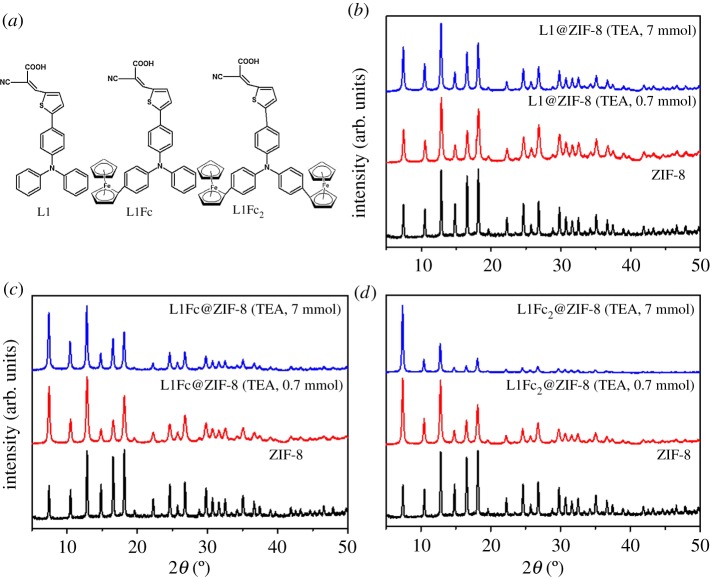
(a) Molecular structures of the encapsulated dyes, and (b–d) XRD patterns of the synthesized dye@ZIF-8 of L1 (b), L1Fc (c) and L1Fc2 (d).